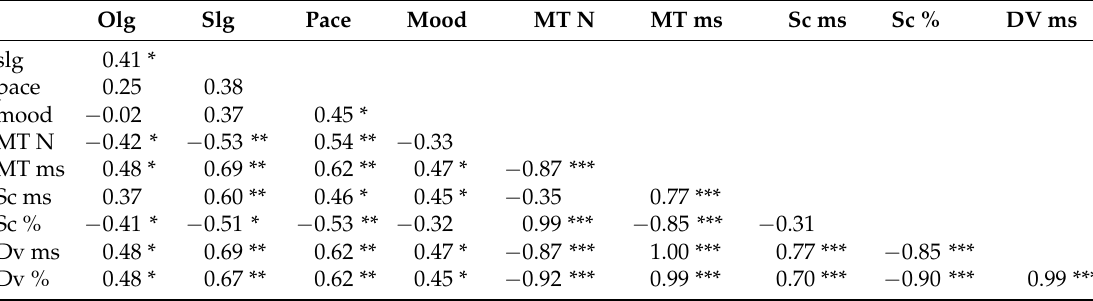
Table 3. Correlations of predictor variables with the significant reception variables and intercorrelations among the